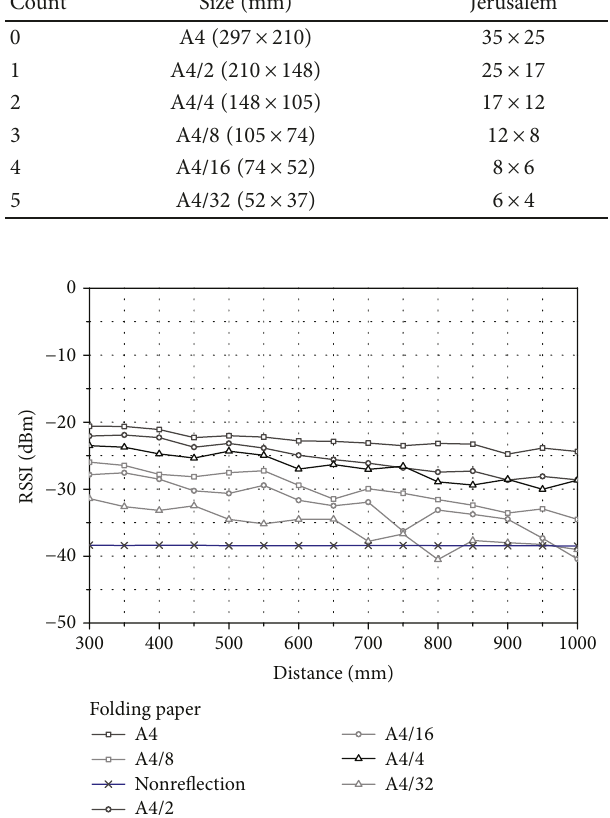
Table 1: Number of unit cell for folding paper. Folding, cutting